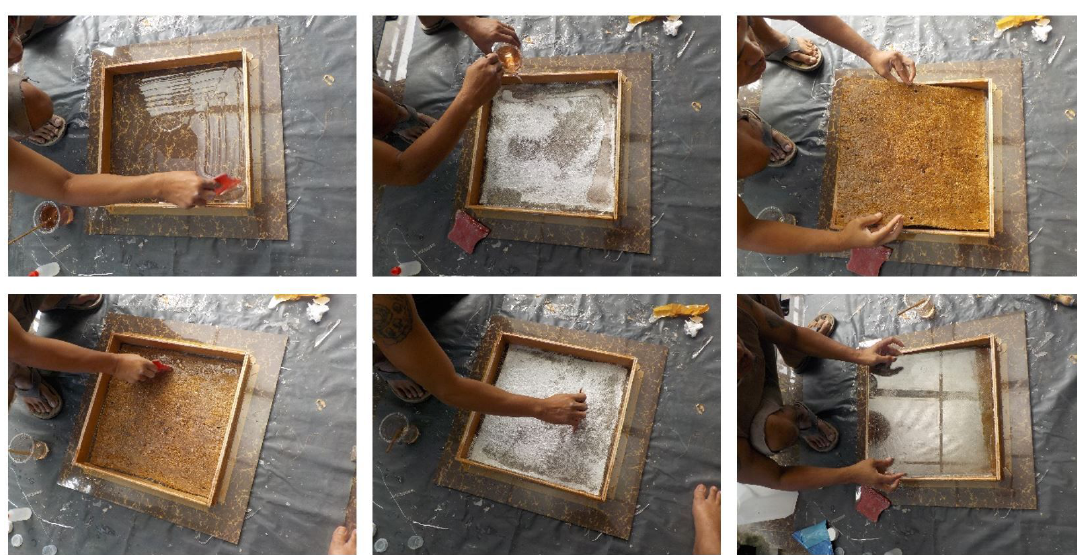
Figure 2: Lamination process using the hand lay-up method to manufacture hybrid coir and glass fiber composite material (HCGFRP)